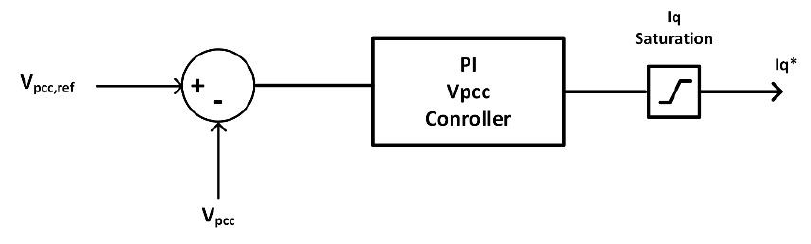
Figure 8. Modified q -axis current control system.